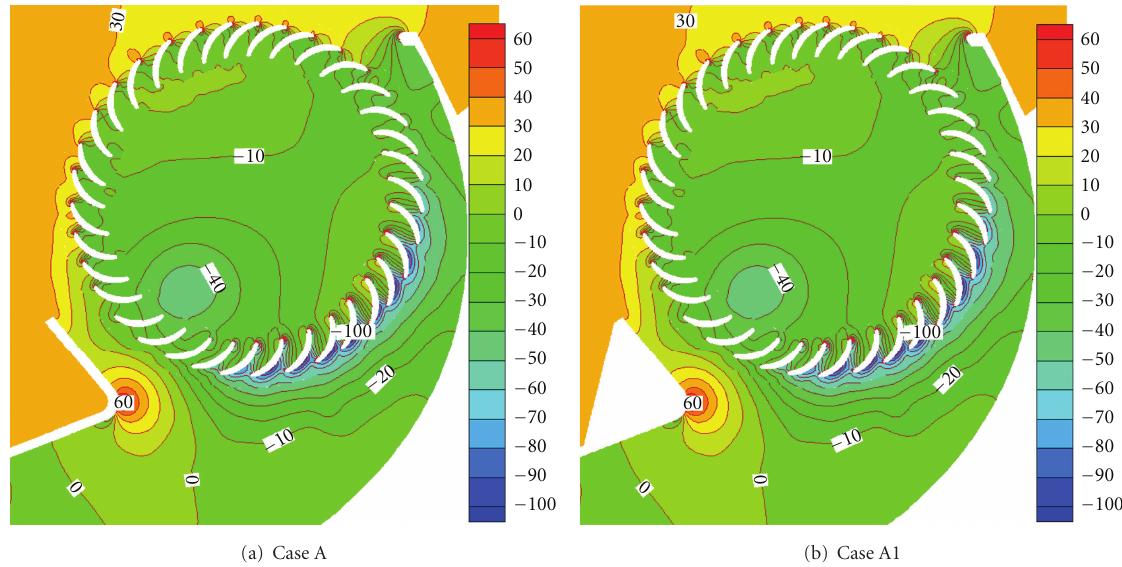
Figure 7: Comparison of calculated instantaneous static pressure contours. The contours for both cases are taken at the end of 4 rotations of the impeller from a same initial field (a) Case A. (b) Case A1.